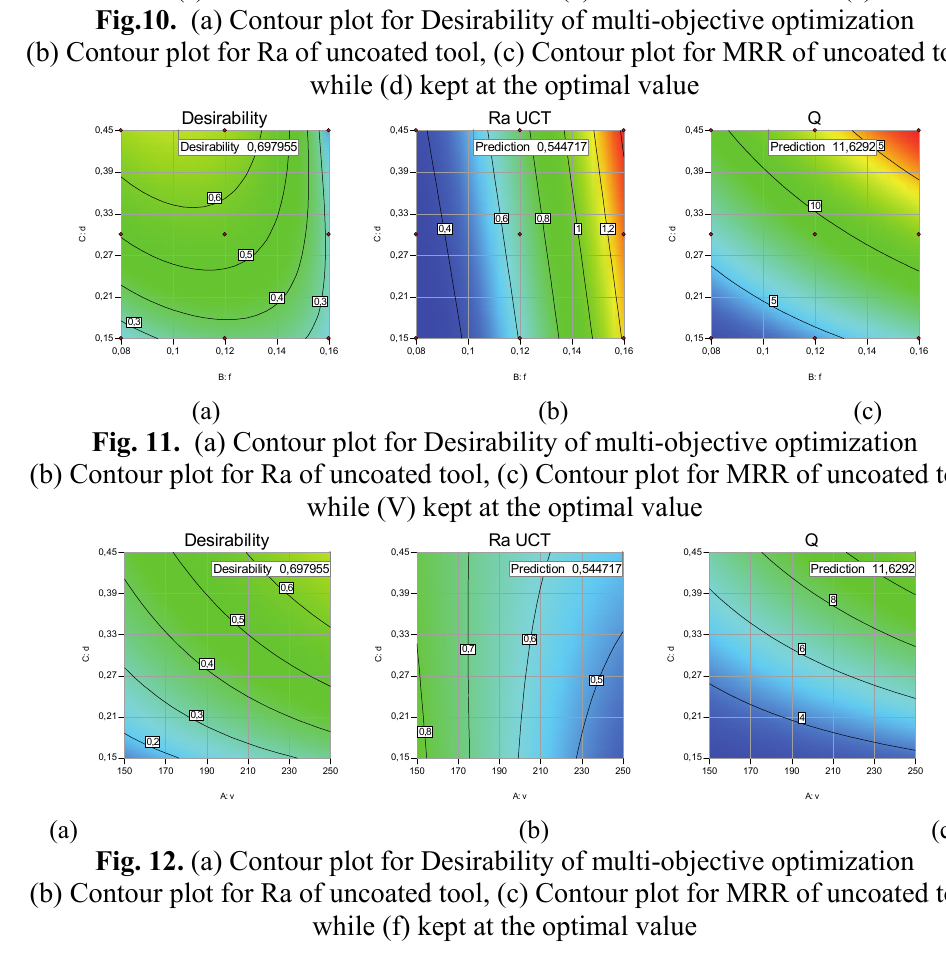
Fig. 12. (a) Contour plot for Desirability of multi-objective optimization (b) Contour plot for Ra of uncoated tool, (c) Contour plot for MRR of uncoated tool while (f) kept at the optimal